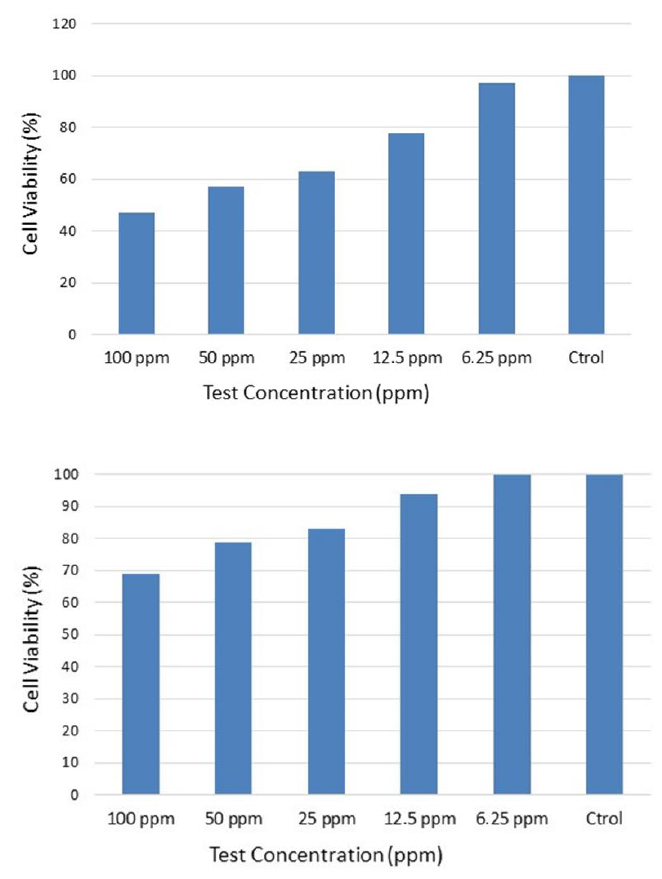
Figure 14. Effect of graphene-related composites on the generation of cytotoxic effects in Caco-2 cells: ( Top ) Pristine nanocomposite; ( Bottom ) graphene-based composite sample (M14, 50% of gra- phene).